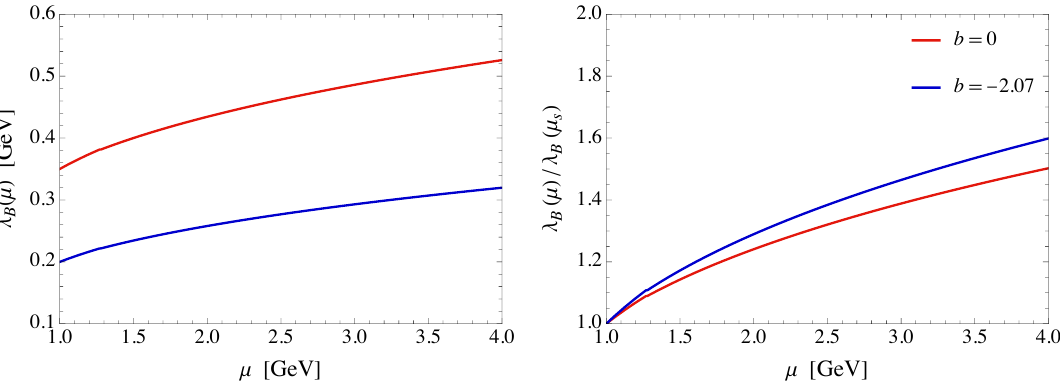
Figure 4 . Scale evolution of the hadronic parameter λ B ( µ ) for the two model functions with b = 0 (red curves) and b = − 2 . 07 (blue curves). The small kink at µ = m c ( m c ) results from the discontinuity of α s ( µ ) at the threshold at which the charm quark is integrated out.